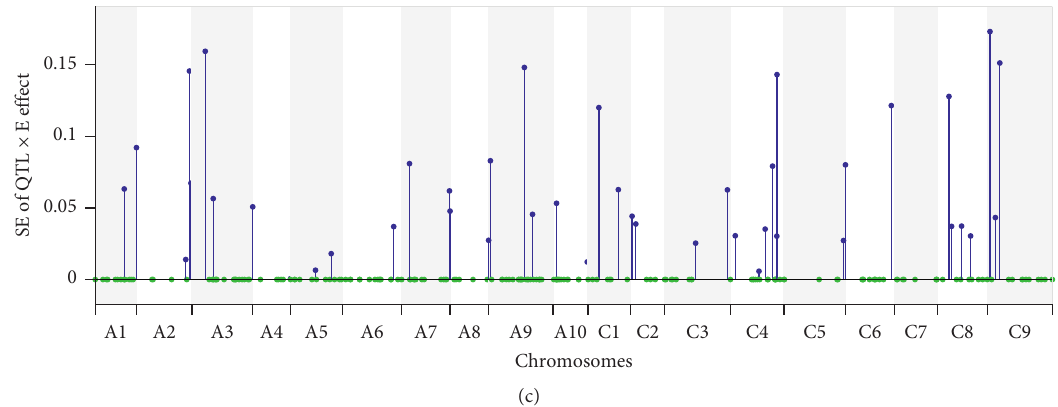
Figure 2: The point estimates and 95% confidence intervals (95% CI) for marker main and environment-specific effects and the standard error (SE) of environment-specific effects for OC. (a) Point estimates (red dots) and 95% CI for main effects (the vertical blue and green CIs represent statistically significant or nonsignificant values, respectively). (b) Point estimates (red dots) and 95% CI for environment-specific effects (the vertical blue and green CIs represent statistically significant or nonsignificant values, respectively). (c) SE for environment- specific effects (the blue and green stems represent environment-specific effects found in multiple environments or only one environment,